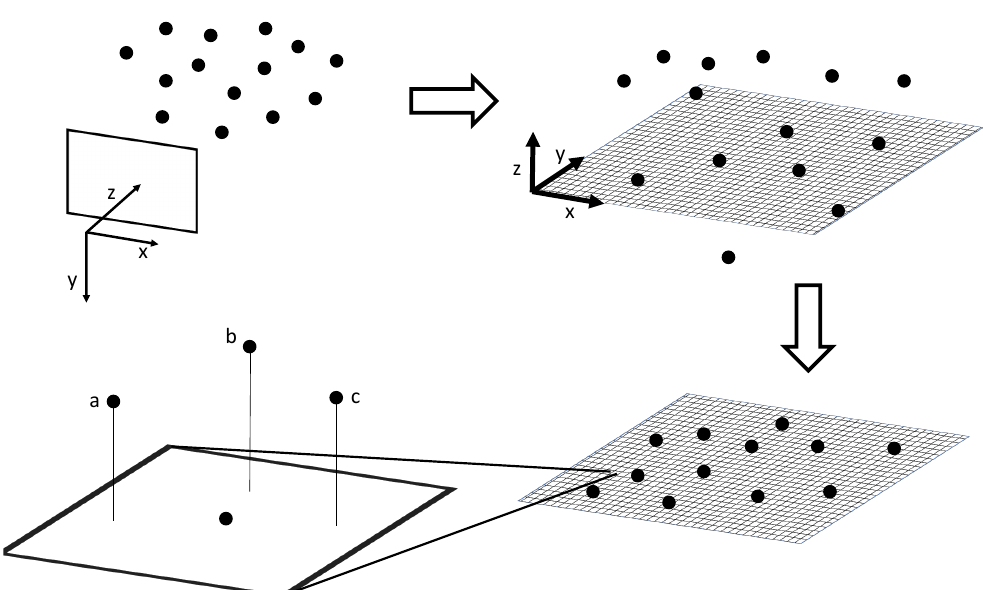
Figure 2. The point discretization process used to prepare data for the subsequent WASSfast CNN. Top-left : initially, points are defined in the left (or right) camera reference system. Top-right : points are transformed to the mean sea-plane reference system spanning the x – y axis with the z oriented upward. Bottom-right : points are parallel projected into the regular grid defined on the mean sea-plane. Bottom-left : A closeup of what happens if multiple points (a, b, c) falls on the same grid cell. A random point is chosen and its x – y coordinates are approximated to the coordinate of the grid cell center. This way, the entire grid cell takes the elevation value of the randomly chosen point.